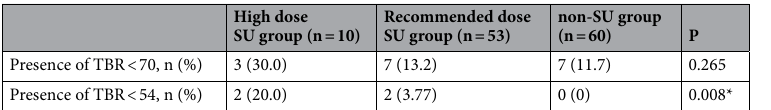
Table 4. Relationship between dose of SU and hypoglycemia. We showed the number of patients who presence of TBR < 70 and < 54. We used Fisher’s exact test. *p < 0.05.